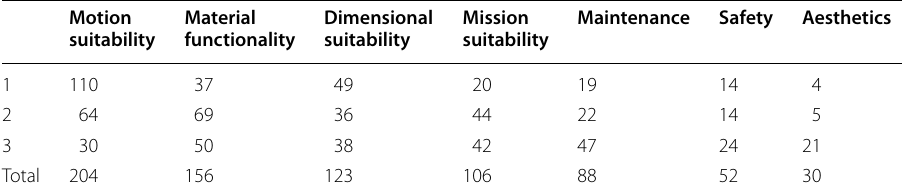
Table 2 Crew members’ priorities for the required performance factors (N